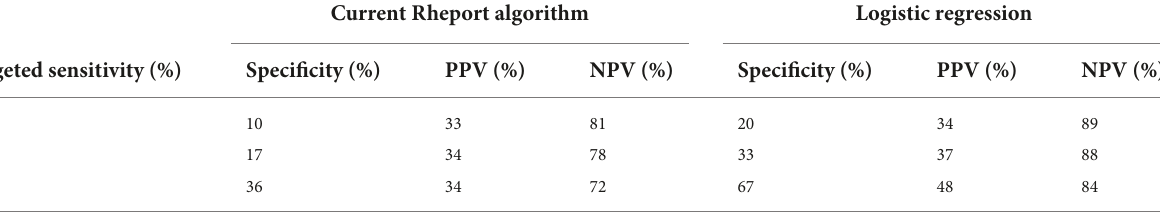
TABLE 4 Specificity, PPV, NPV of current Rheport algorithm and best performing machine learning model according to targeted sensitivity. Current Rheport algorithm Logistic